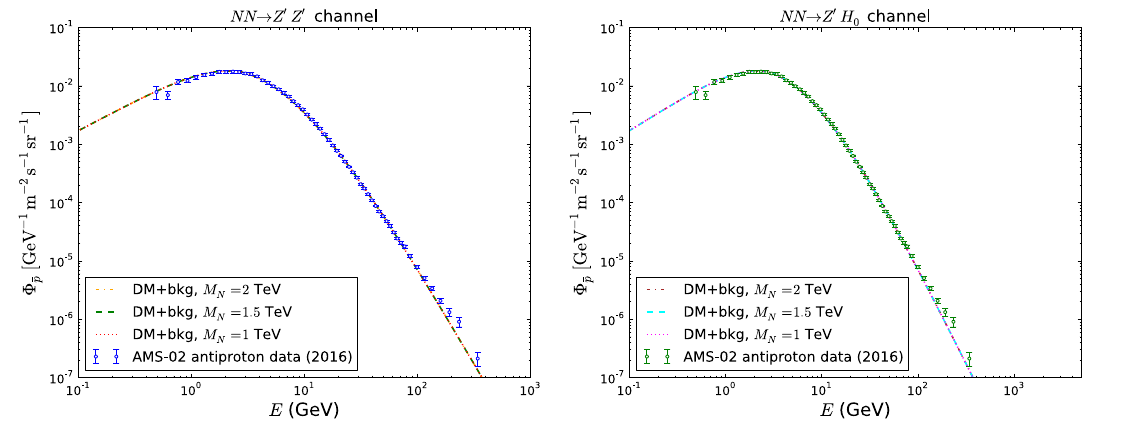
Fig. 7 The antiproton flux predicted by benchmarks in Tables 3 and 4 with the AMS-02 data